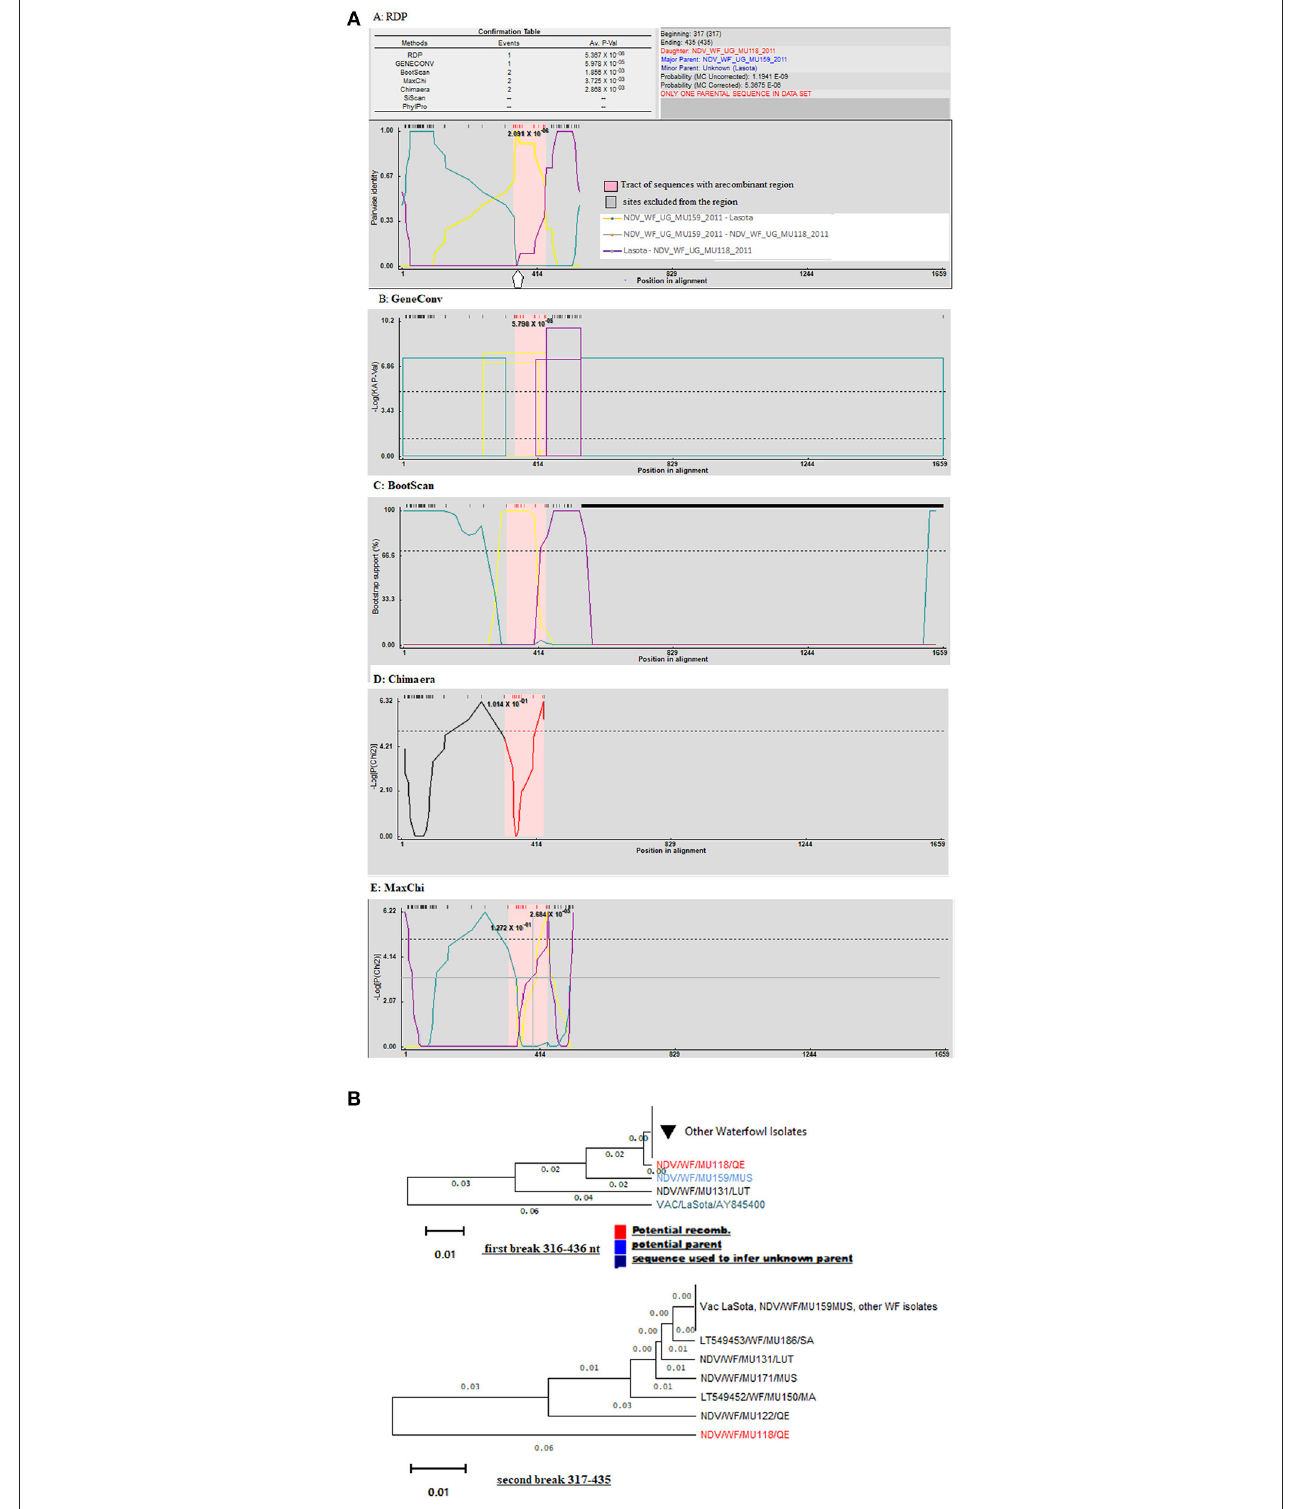
FIGURE 3 | Graphic representation of recombination in fusion gene of Avian Avulavirus es. (A) Lines forming an open rectangle connects the beginning and the end of a fragment that underwent recombination. The height of the open rectangle is proportional to –log10 of the probability. (B) Phylogenetic trees for different regions of F gene showing the movement of recombinant fragments (red colored) in the NDV isolates from waterfowl. Trees were generated with the RDP program (version 4) by using UPGMA analysis of region derived from both major and minor parents. Bootstrap values (percentage from 1,000 replicates) were shown for the relevant nodes.